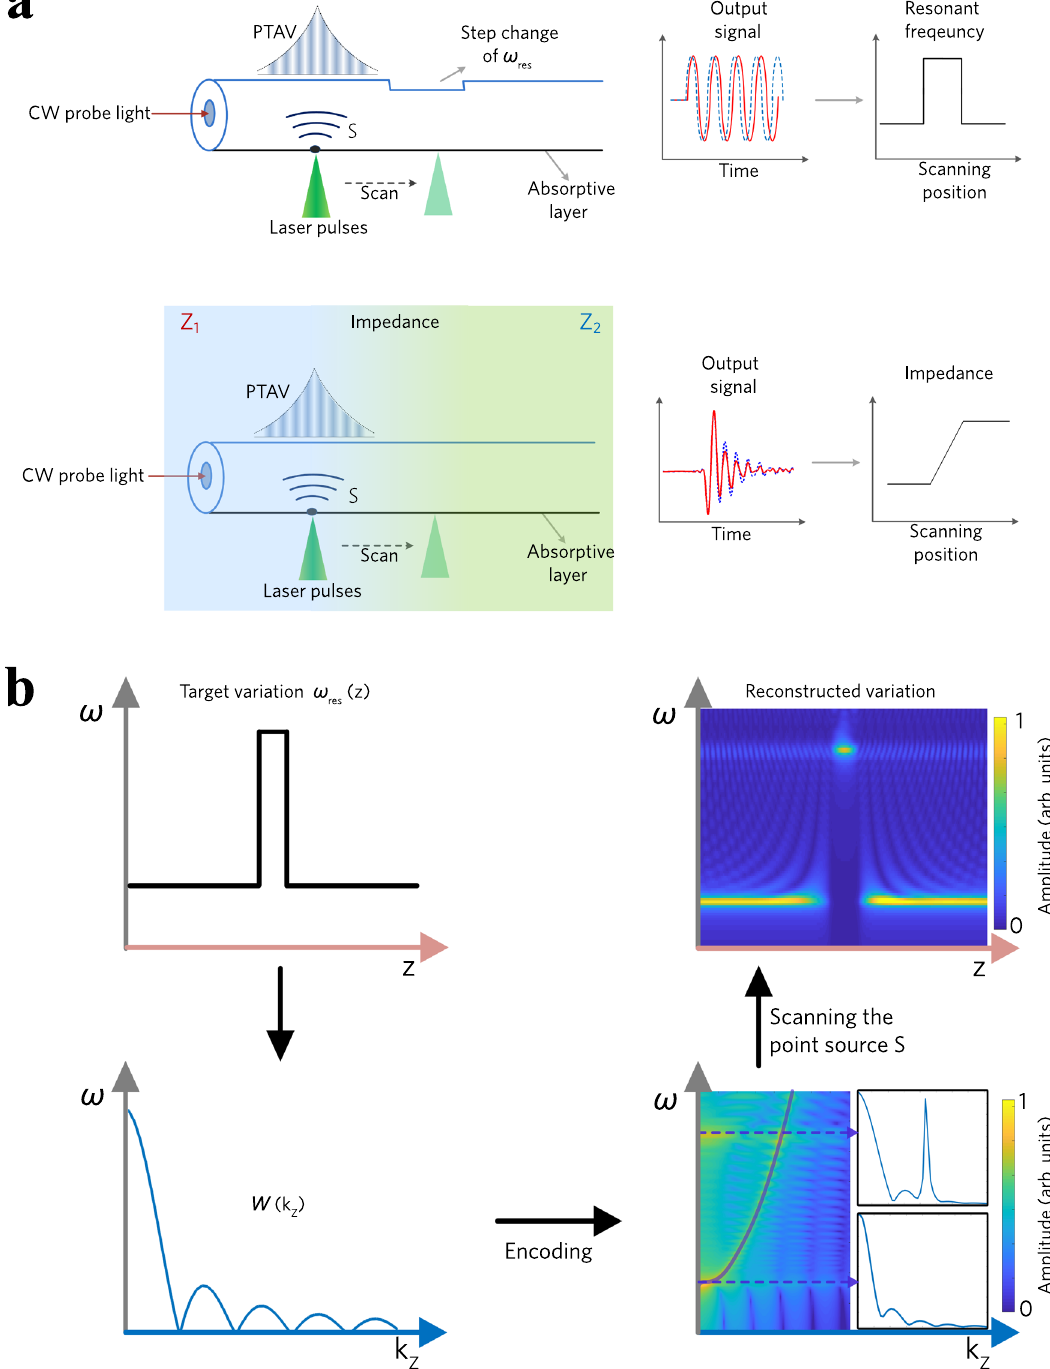
Fig. 1 Principle of PTAV-based optoacoustic sensing in an optical fi bre. a Conceptual illustration. The absorption of laser pulses on the fi bre surface can photothermally actuate acoustic vibrations. The resonance spectrum of the transverse structure can be recovered through fi bre-optic measurements, which allow for continuous measurement of the resonance-frequency variation (upper) and surrounding acoustic impedance (lower) by scanning the excitation laser beam. b Diagram showing the sensing mechanism. Here, the fi bre has a step change in resonant frequency ω res ( z ), for example. The spatial information of the fi bre is encoded in the k z -space dispersion diagram and reconstructed via mechanical scanning of the optically induced acoustic source. The original resonant frequency is ω res = 2 π ´ 22 MHz, the introduced frequency step is 4 ω res ¼ 2 π ´ 150 kHz, the spatial width of the step is 200 μ m, and the acousti c velocity is c a = 500 m s − 1 . CW, Continuous wave. S,